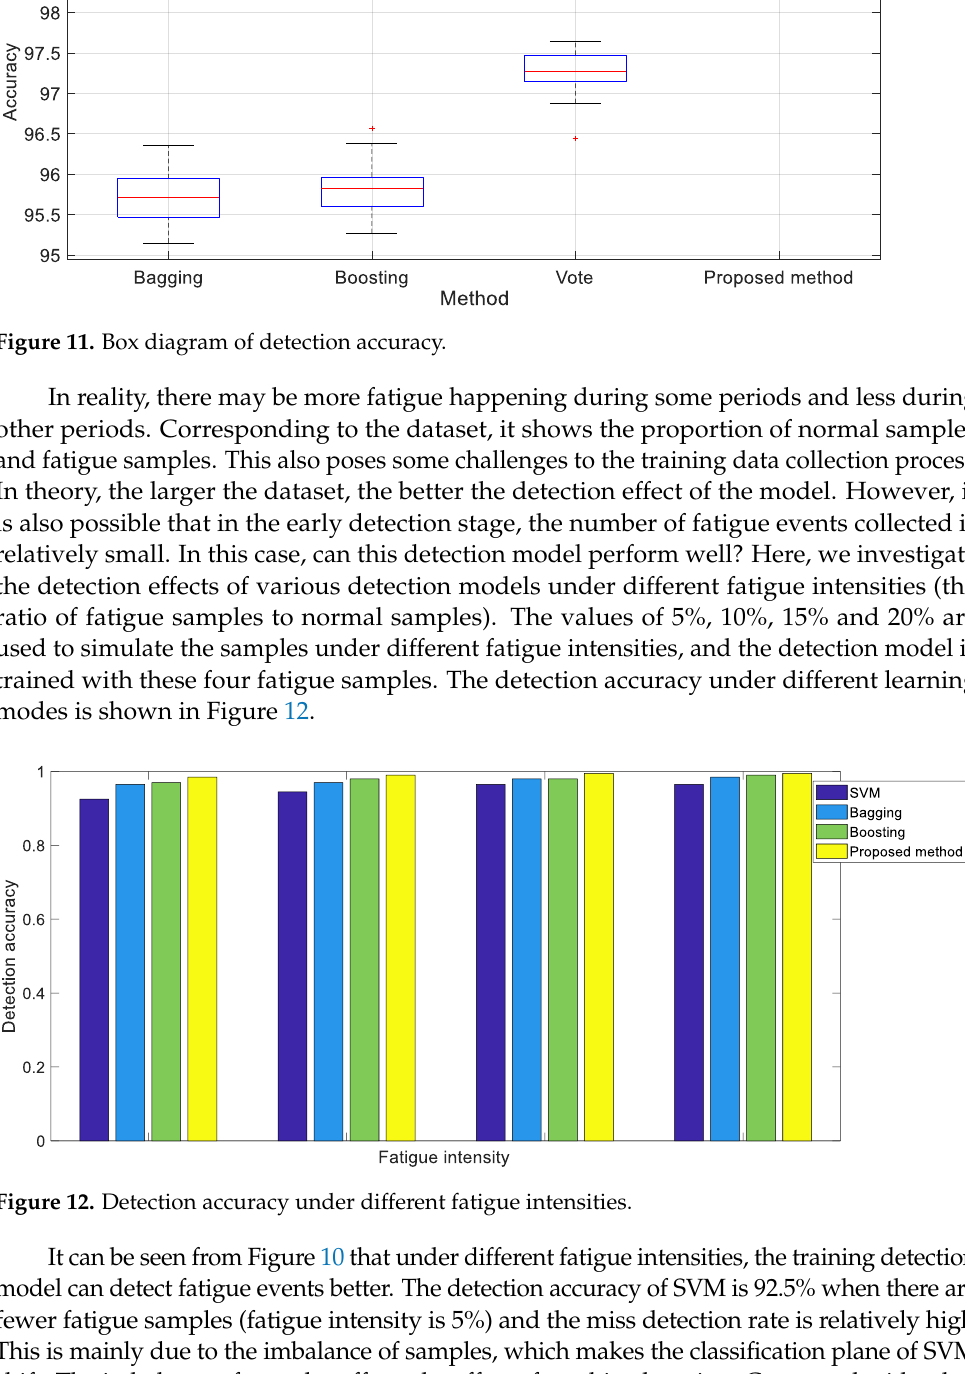
Figure 10. Box diagram of false negative rate.